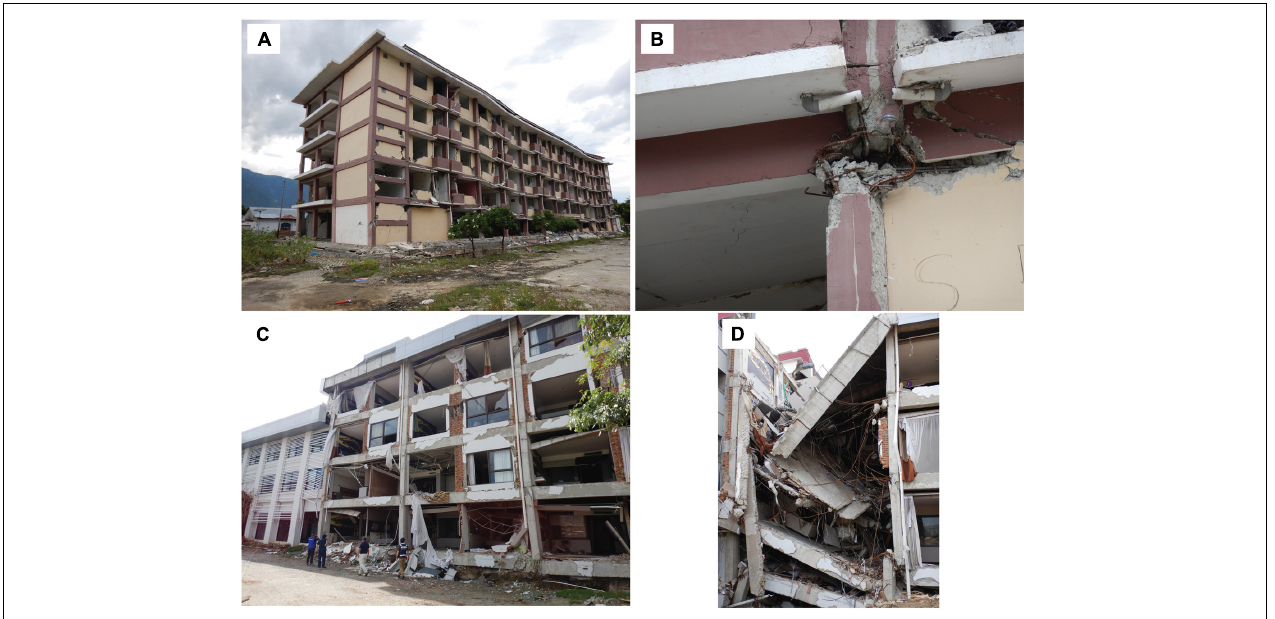
FIGURE 3 | Observed earthquake-shaking damage in the Palu bay area (point 4 in Figure 2 ): (A,B) damage to a 5-story reinforced concrete apartment and (C,D) damage to Mercure